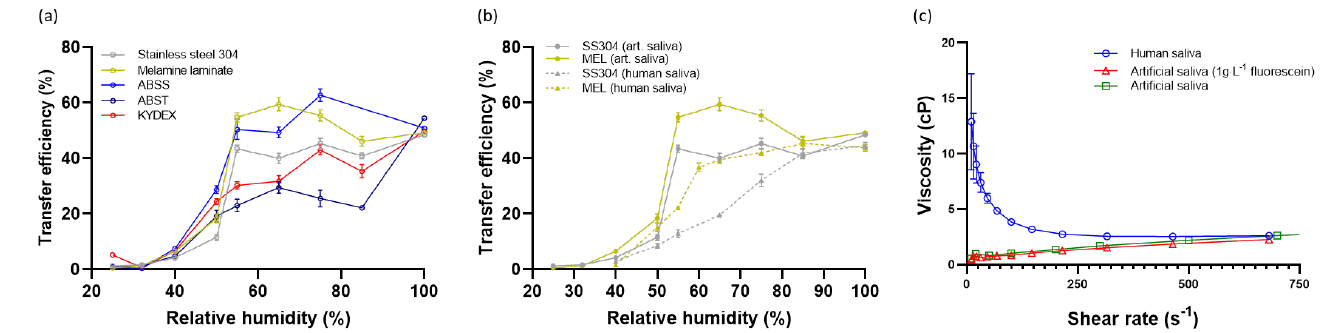
Figure 6. Effect of relative humidity on transfer from surfaces to artificial finger-pads. ( a ) Artificial saliva, ( b ) pooled human saliva, and ( c ) rheological properties of artificial and human saliva. Values are mean ± standard error. Note: the 100% values correspond to immediate transfer of a 1 µL deposited droplet (i.e., within 5 s of deposition).